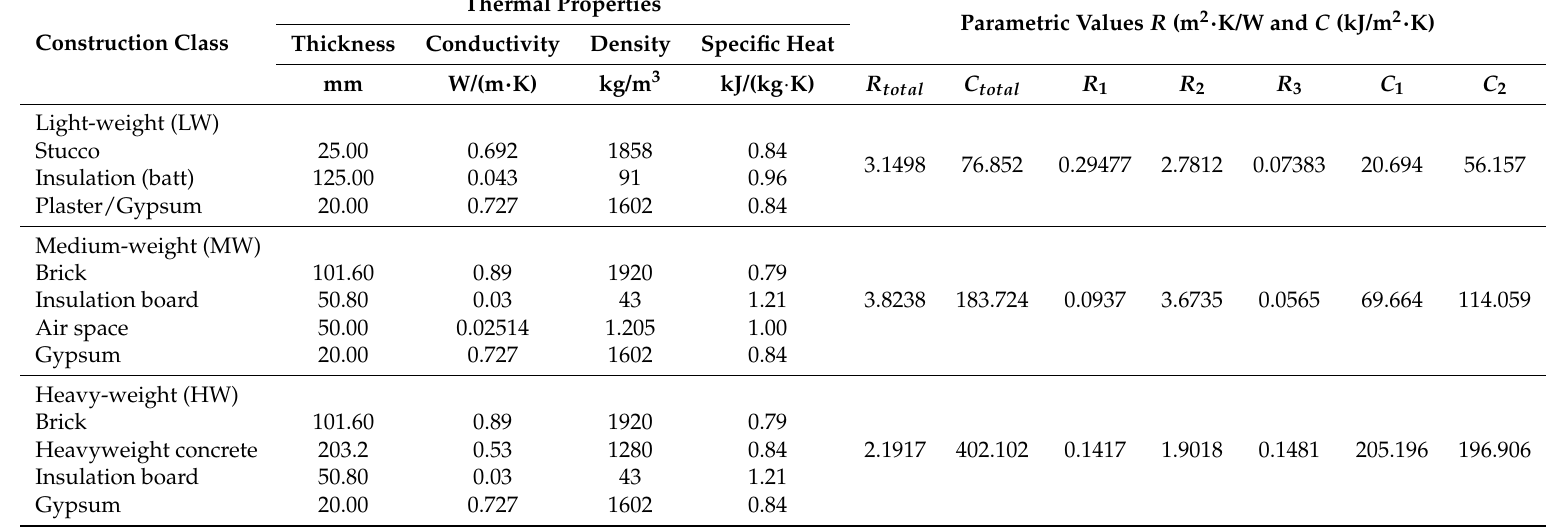
Table 2. Multilayer wall classification, thermal properties, and optimized R and C